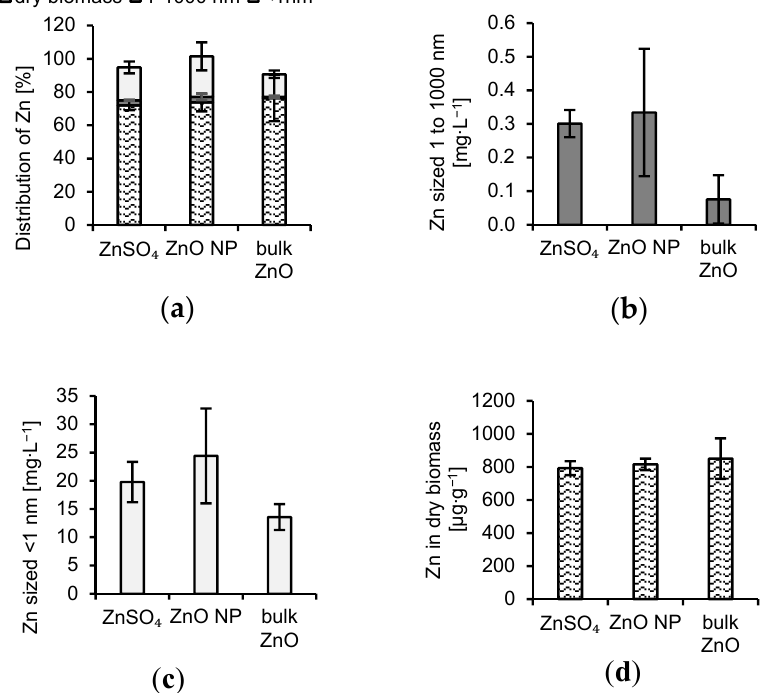
Figure 2. Distribution of Zn in the experimental system ( a ) and concentration of Zn in ( b ) particles sized 1 to 1000 nm, ( c ) dissolved fraction, and ( d ) dry biomass.